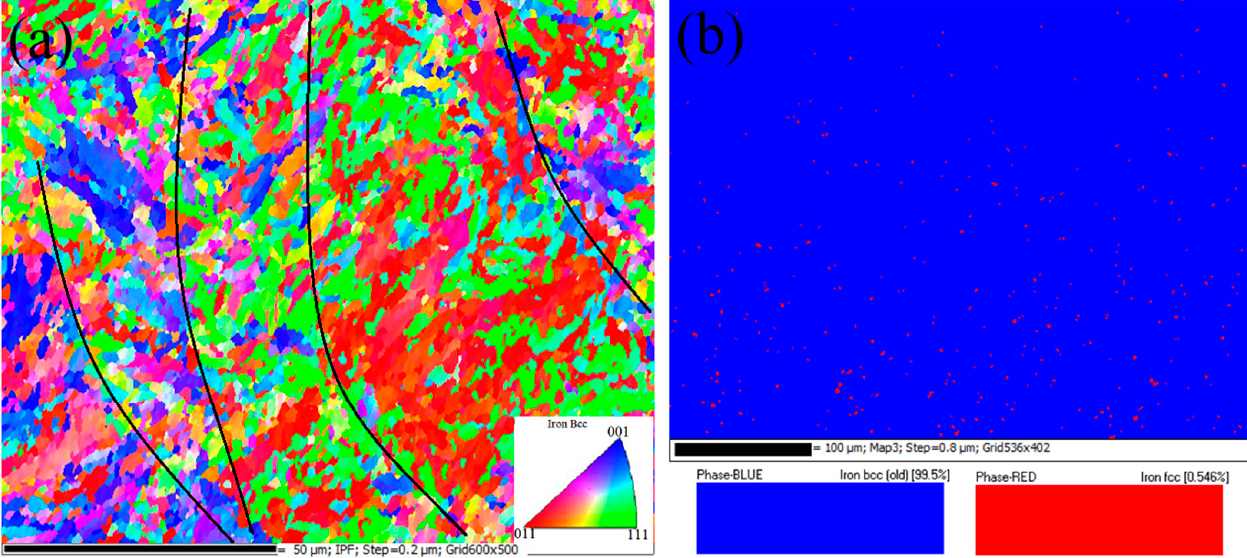
Figure 6. The EBSD ( a ) orientation and ( b ) phase distribution of the SLM sample.